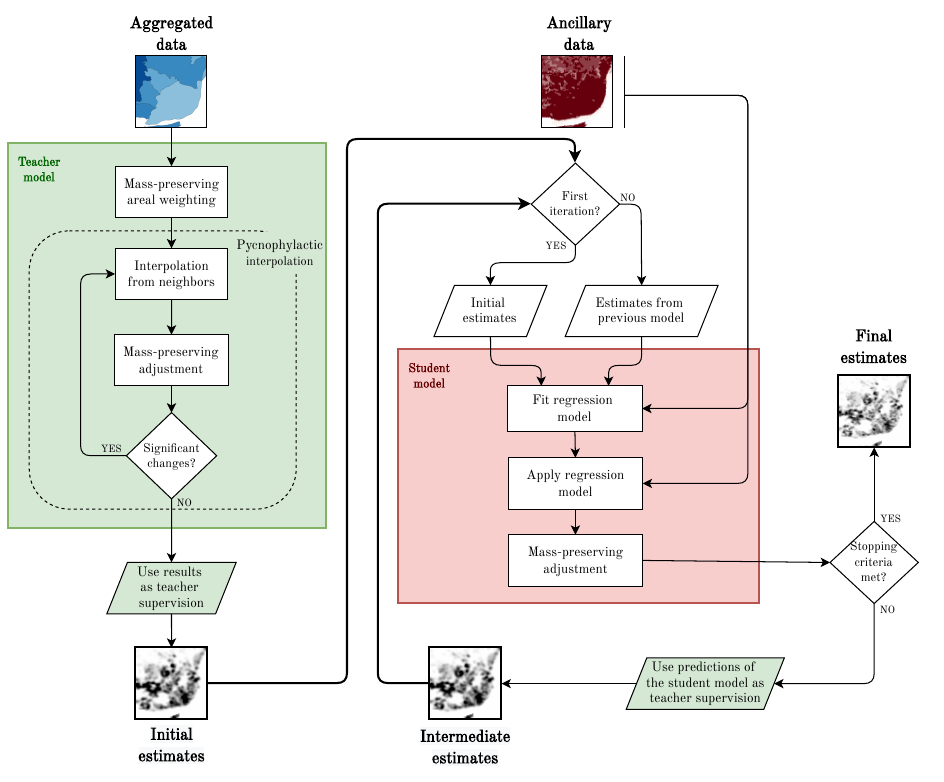
Figure 1. The different steps involved in the proposed disaggregation method, considering the use of initial disaggregation weights based on pycnophylactic